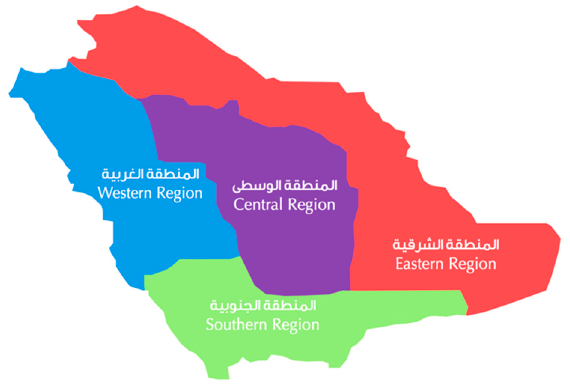
Figure 6. Power operation areas of Saudi Arabia [57]. Source: SEC.